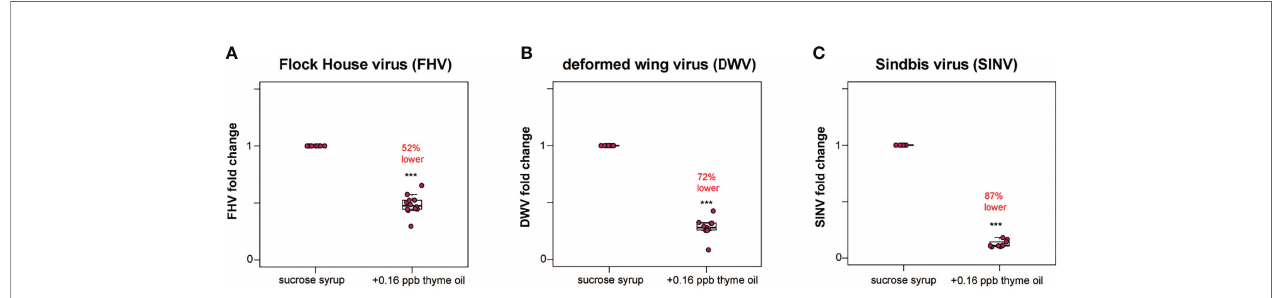
FIGURE 1 | Lower virus abundance in honey bees fed thyme oil augmented sucrose syrup. Virus abundance in individual honey bees that were either fed sucrose syrup only or sucrose syrup augmented with 0.16 ppb thyme oil was assessed at 72 h post-infection by qPCR (n = 9-12 per treatment group) and the relative virus abundance is presented as ranked fold-changes. Together, these data illustrate that virus-infected bees fed thyme oil augmented sucrose syrup harbored less virus than virus-infected bees fed only sucrose syrup. (A) Flock House virus (FHV)-infected bees fed sucrose syrup augmented with thyme oil (0.16 ppb) had 52% less FHV (0.48 mean fold change) than bees fed sucrose syrup alone (p = 2.1 x 10 -5 ). (B) In deformed wing virus (DWV)-infected bees, virus abundance was 72% less in bees fed sucrose syrup augmented with thyme oil (0.28 mean fold change) compared to bees fed only sucrose syrup (p = 0.00016). (C) Sindbis virus (SINV)-infected bees fed thyme oil augmented sucrose syrup had 87% less SINV (0.13 mean fold change) than bees fed sucrose syrup. Data were analyzed by a pairwise Wilcoxon Rank Sums with a Benjamini – Hochberg correction for multiple comparisons. Asterisks indicate a signi fi cant difference in virus abundance; signi fi cance levels: *** p < 0.0005. This fi gure includes results from one representative biological replicate for each virus (i.e., rep1). The data for all three biological replicates are presented in Supplemental Figure S2 and raw data are in Supplemental Tables S3, S4 .